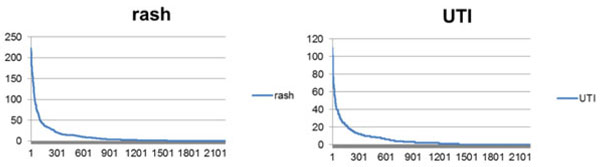
Literature-based co-occurrence score distribution of 2 side effects. Top 20 processes are omitted in this graph because of range problem